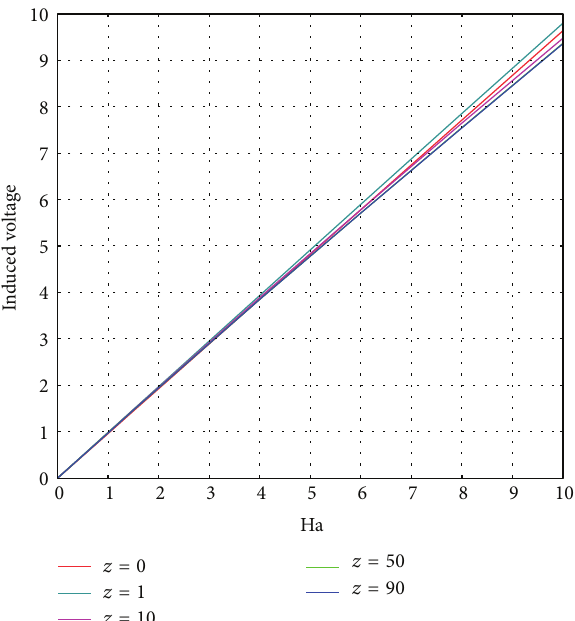
Figure 17: Effect of steady entrance length on induced voltage with Hartmann number